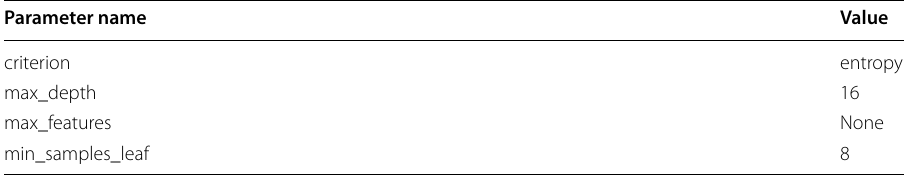
Table 77 Modes of DT tuned hyperparameter values for experiments with the data exfiltration dataset